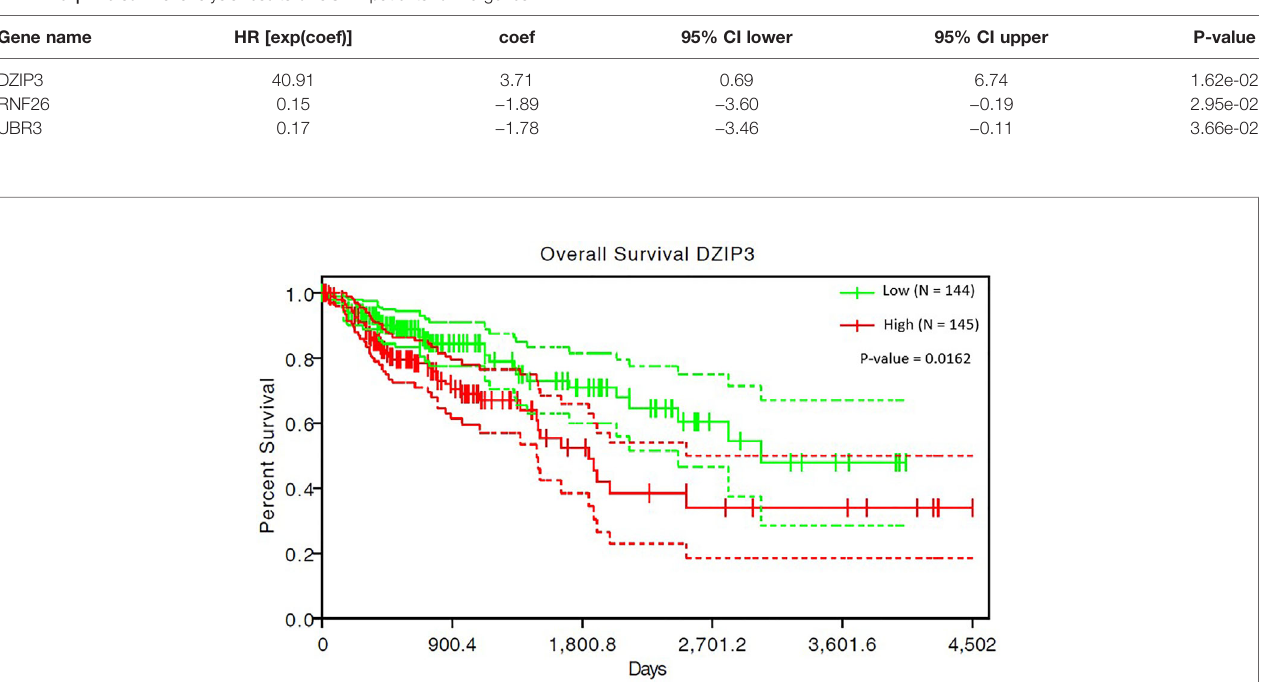
TABLE 5 | The survival analysis results of COAD patients for E3 genes.